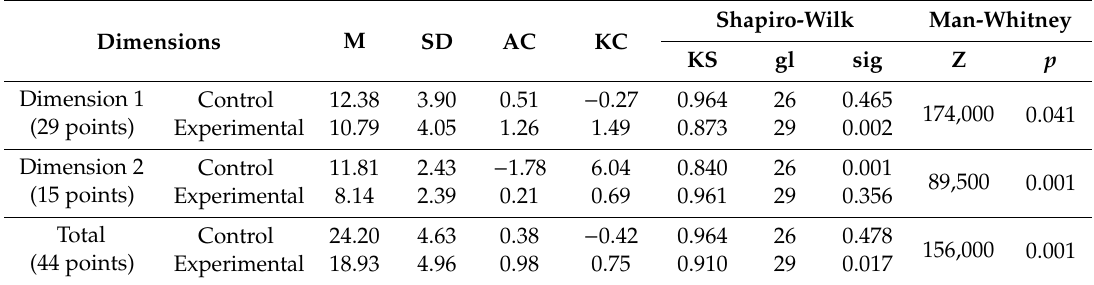
Table 6. Comparison between the control and experimental groups after applying the program.